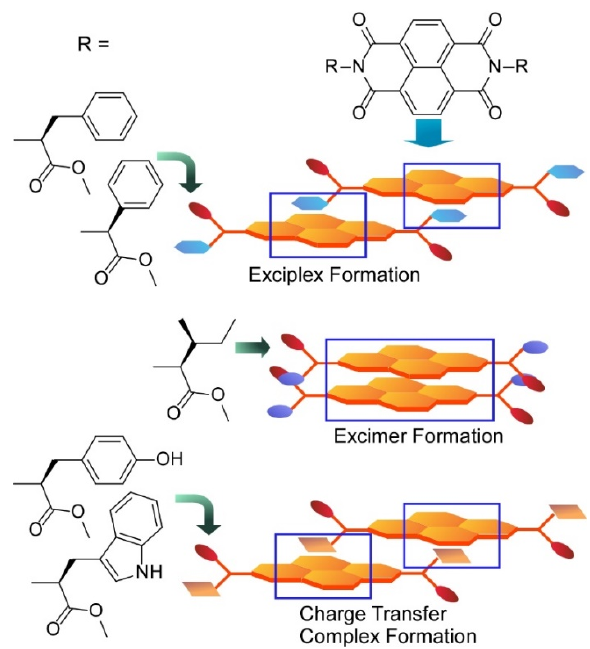
Figure 23. Assembling structures of naphthalenediimides conjugated with amino acid to form exciplex, excimer, and charge transfer complex depending on α -substituent of amino